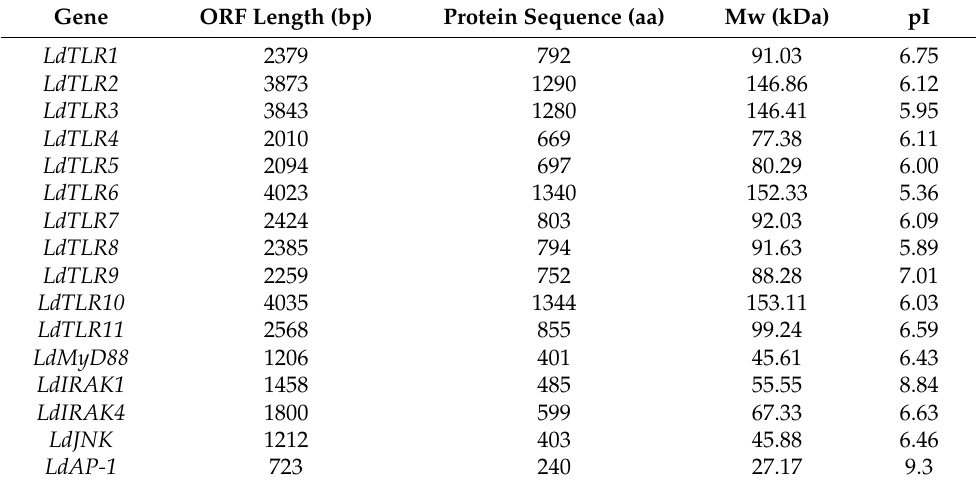
Table 2. Characterization of identified core genes of TLR signaling pathway in L. dispar .